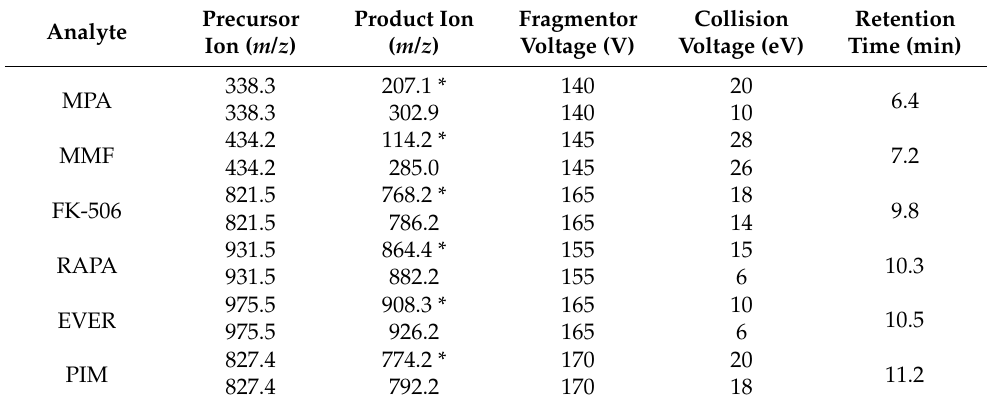
Table 4. The MS/MS fragment ions, fragmentor voltage, collision voltage and retention time of the 6